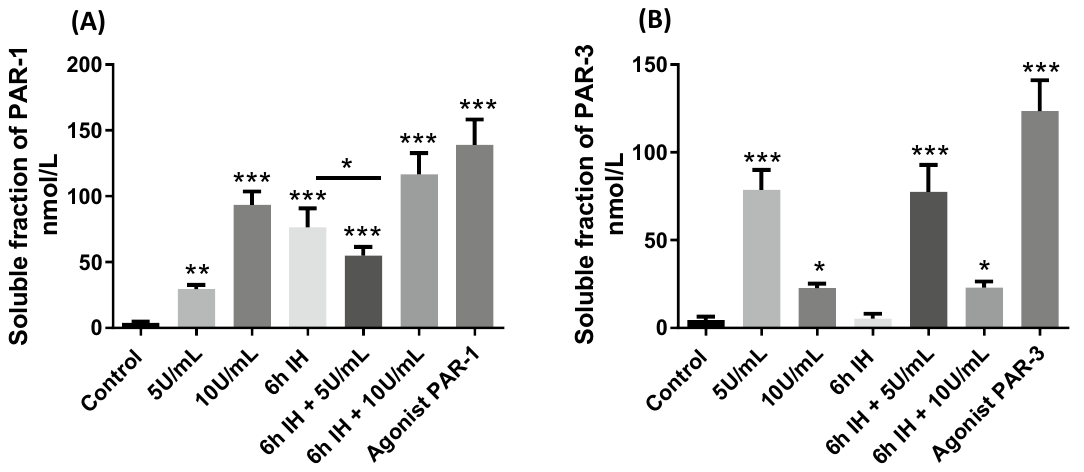
Figure 4. Evaluation of the expression of the soluble fraction of PAR-1 ( a ) and PAR-3 ( b ) in the supernatant of HBEC-5i after different treatments. For treatment with thrombin, cells were exposed to thrombin at 5 or 10 U/ mL for 1 h. Then cells were also exposed to 6 h of IH alone or associated with thrombin at 5 or 10 U/mL during the last hour. Values are presented as mean value ± SD ( n = 6, N = 3), * p ≤ 0.05, ** p ≤ 0.01, *** p ≤ 0.001 compared to control condition. IH: intermittent hypoxia, PAR: protease activated receptor.